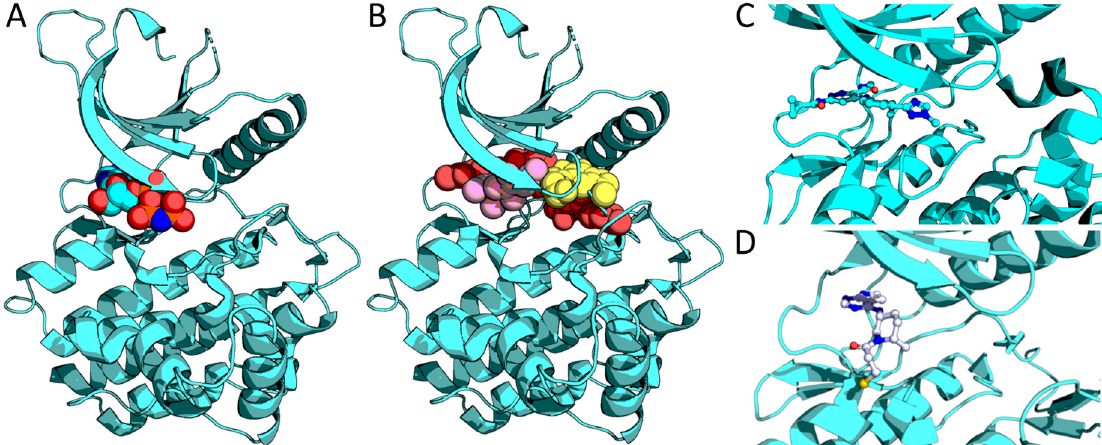
Figure 3. Inhibitor binding sites. ( A ) ATP binding site of JAK kinases. ( B ) Binding sites for type I inhibitors (pink), type II inhibitors (red), and type III inhibitors (yellow). ( C ) Close-up view of a TYK2 JH2-inhibitor complex with a type I binding mode (pdb 6nzp) ( D ) Close-up view of a JAK3 JH1-covalent inhibitor complex (pdb 5toz).